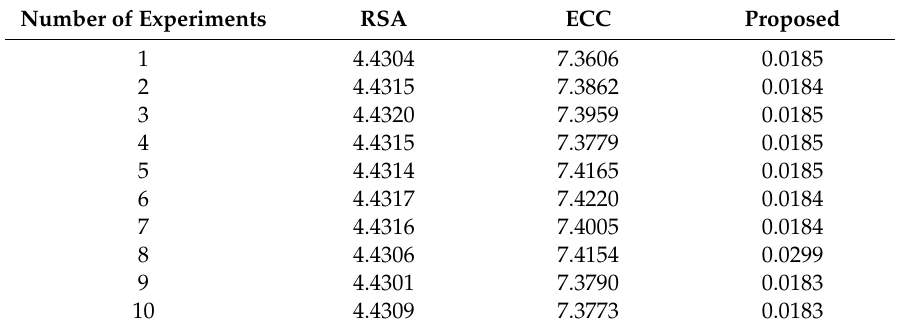
Elapsed time (ms) to check the encoding speed when using the RSA, ECC, and proposed